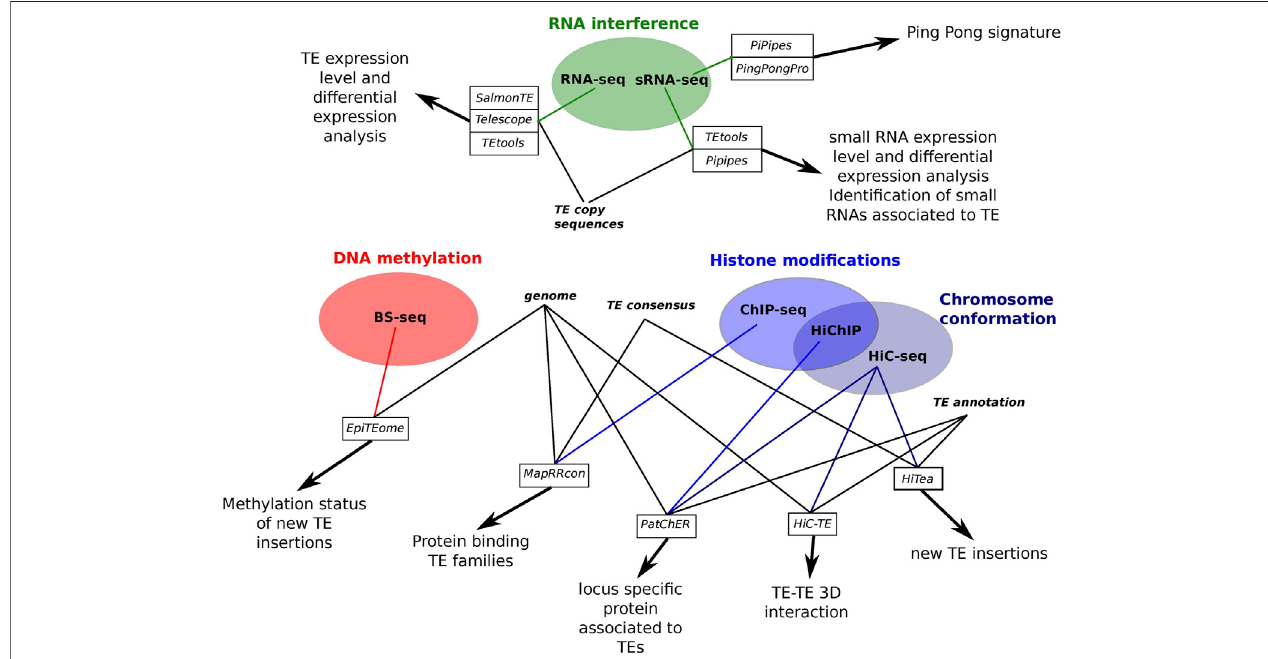
Algorithm for read mapping and